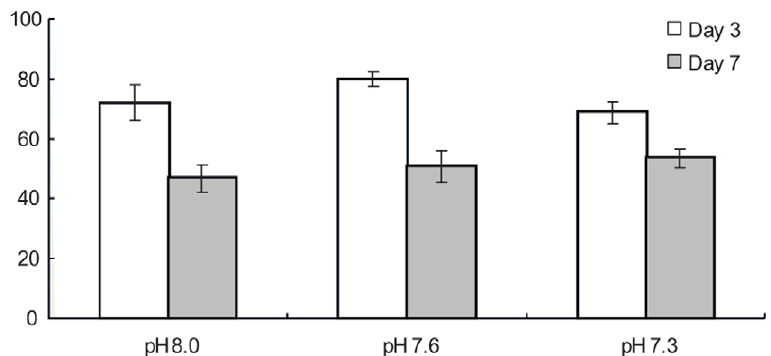
Figure 2. Survivorship of planula larvae of Acroporadigitifera . Survival rates of the larvae after 3 d (Day 3) and 7 d (Day 7) treatments relative to the number of larvae before initiation of the experiment (Day 0) were compared among three different pH conditions. Bars indicate means and standard errors ( n =12).